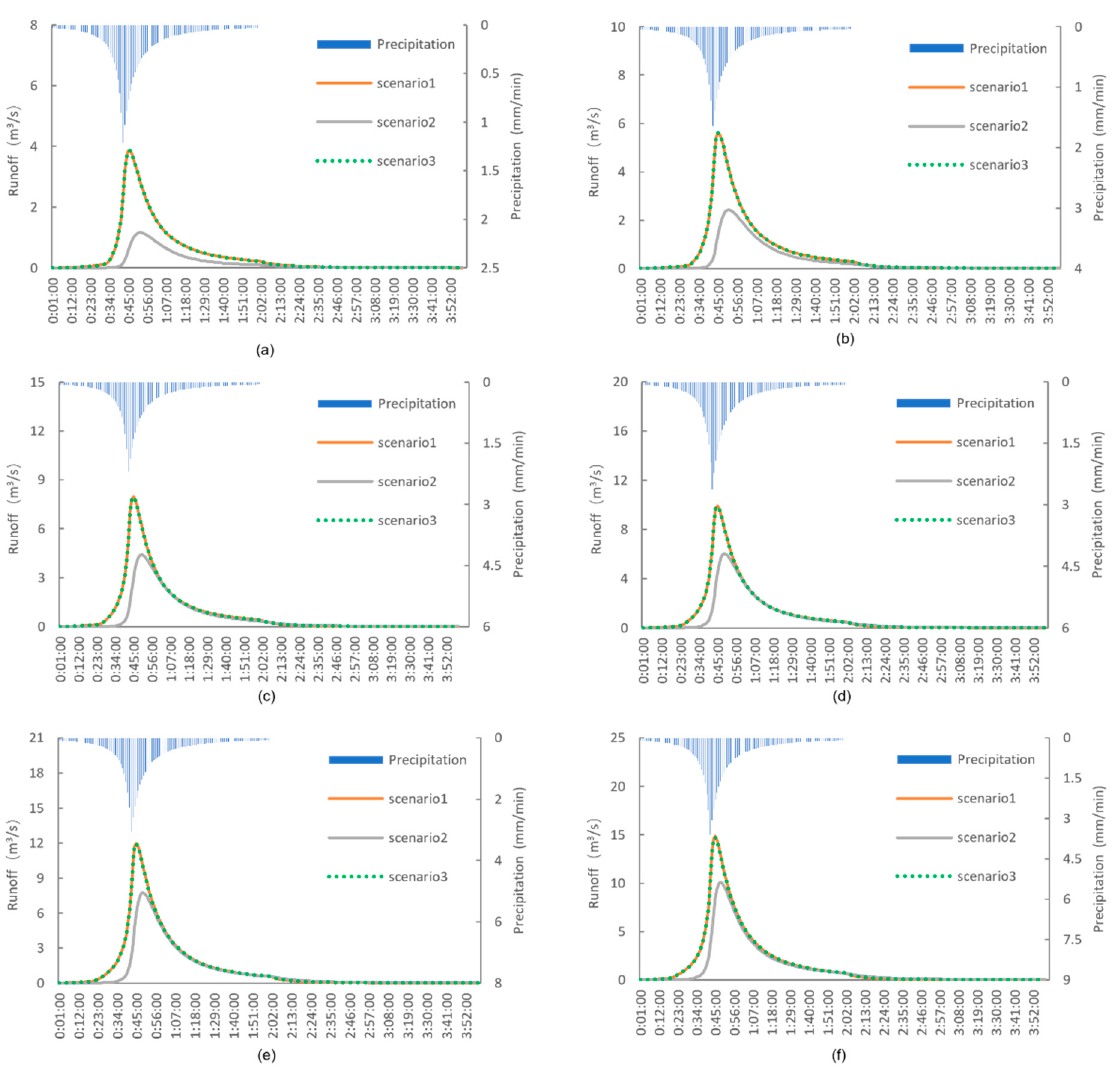
Figure 3. Runoff control effect under different return periods: ( a ) When return period is 1a; ( b ) When return period is 2a; ( c ) When return period is 5a; ( d ) When return period is 10a; ( e ) When return period is 20a; ( f ) When return period is 50a.